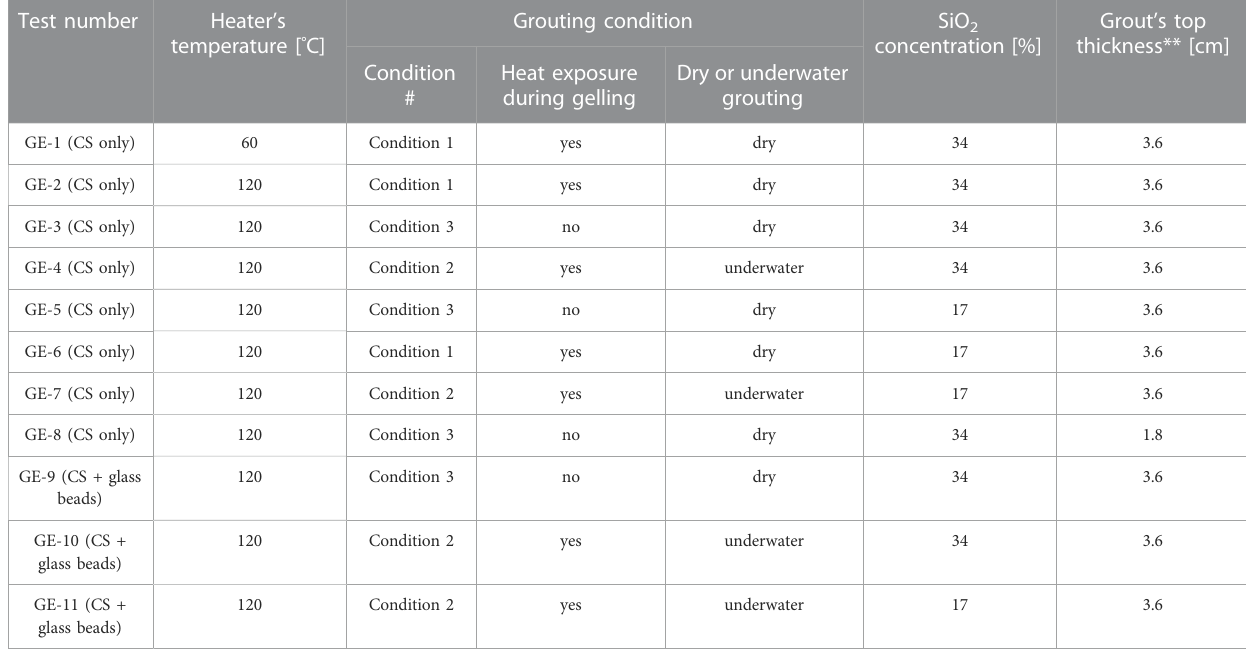
TABLE 4 Summary of grouting experiments (GE). **The top thickness of the groutis intended as the distance between the top of the heater and the top surface of the grouted volume. Test